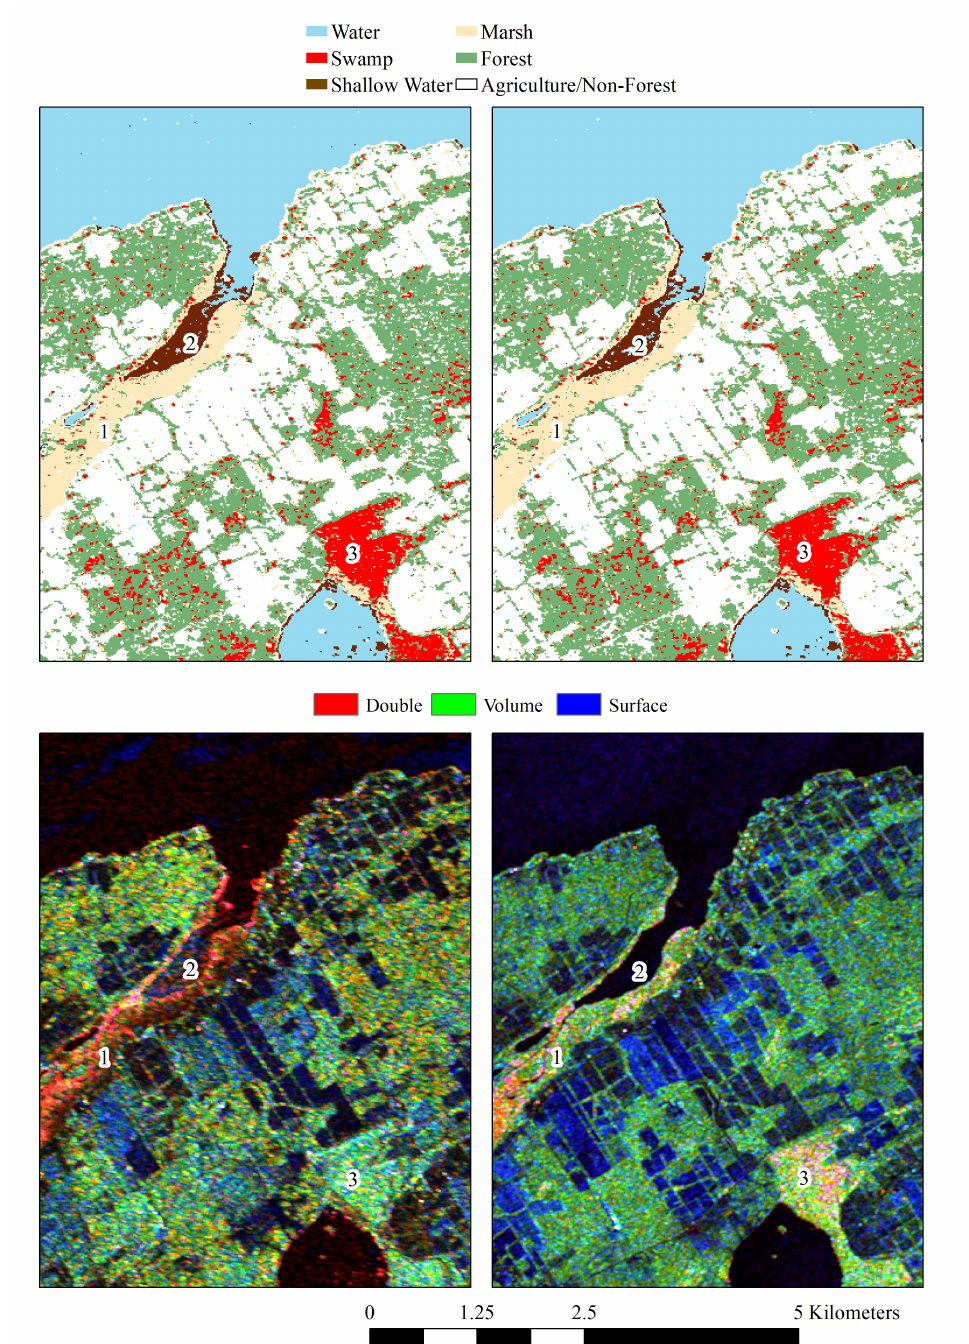
Figure 2. Top shows classifier results for the second simulation of medium resolution (NESZ − 25 dB) CP data that included the FQ5W summer and FQ17W spring imagery, orthorectified using the high spatial resolution DEM, and based on all 25 variables (left), versus the top 10 (right). Examples of marsh (1), shallow water (2), and swamp (3) are indicated. For comparison, results of the m -chi decomposition indicating the proportion of total power attributable to double bounce (red), volume (green), and surface (blue) scattering are provided for the FQ5W summer (bottom left) and FQ17W spring (bottom right) images